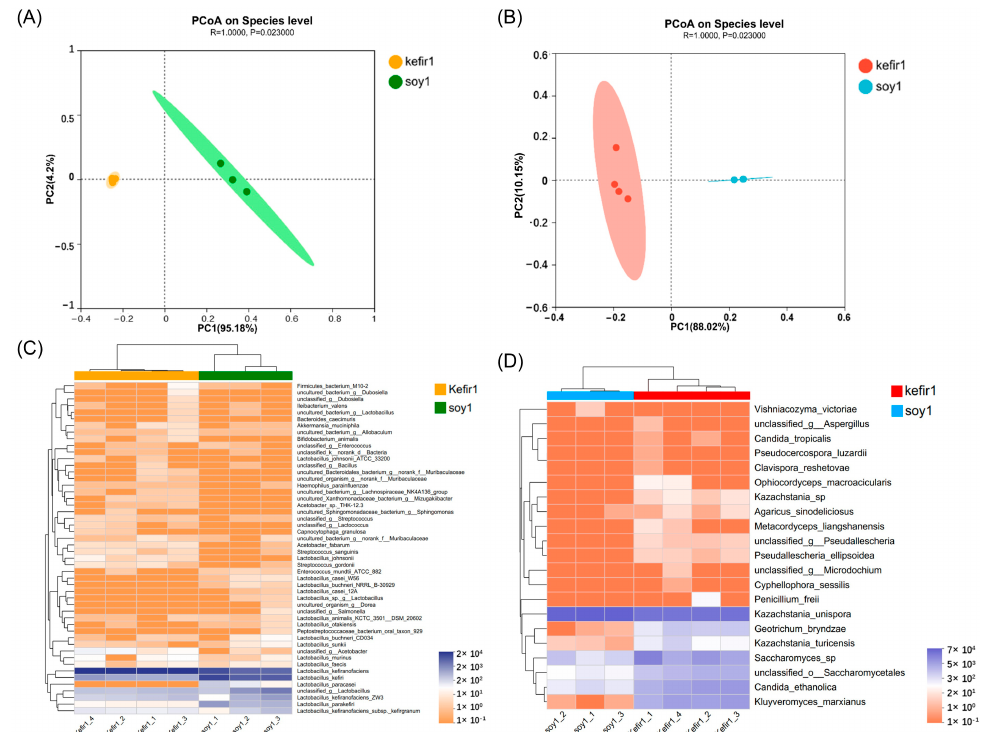
Figure 3. PCoA graphs of bacterial ( A ) and fungal ( B ) communities based on Bray–Curtis distance at the species level. Each point represents an individual sample. Heat map of the relative abundance of predominant bacterial and fungal species in kefir grains and soybean kefir grains (( C )—bacteria, ( D )—fungi).